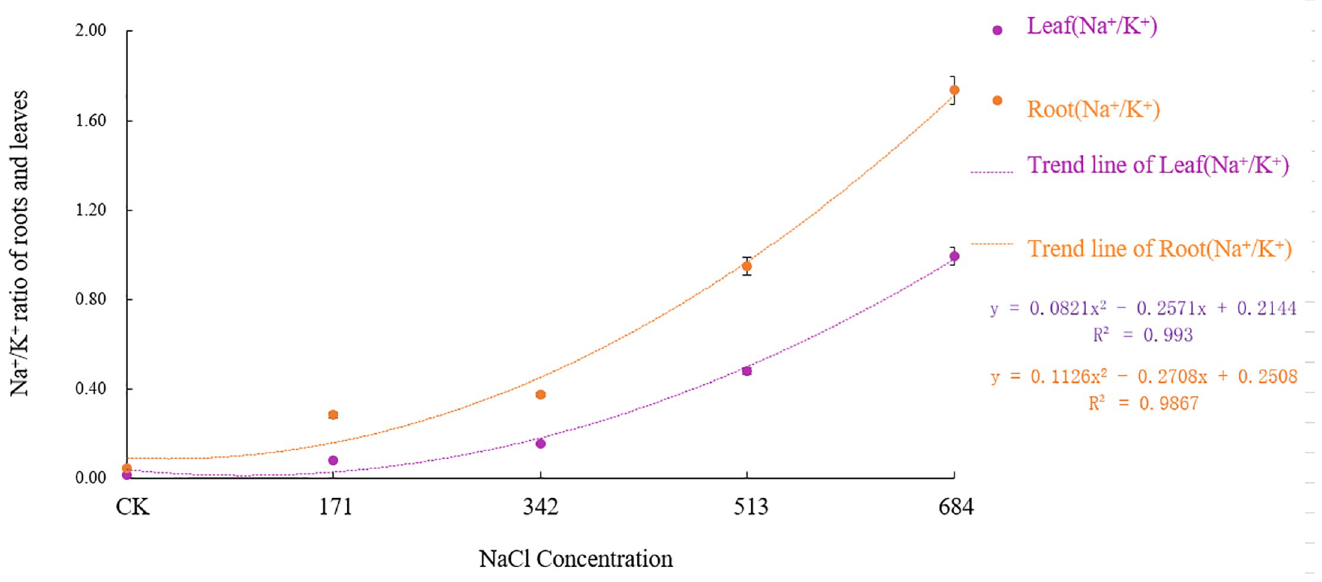
Fig 6. Effects of salt stress on Na + / K + in roots and leaves of Salix alba L.